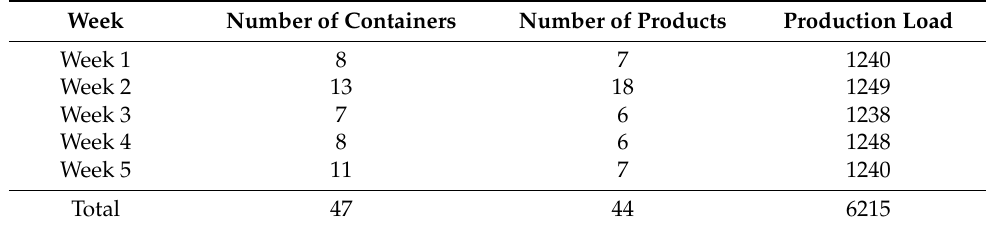
Figure 7. Output of decision variables x and y for Case 2 in the form of Excel spreadsheet.